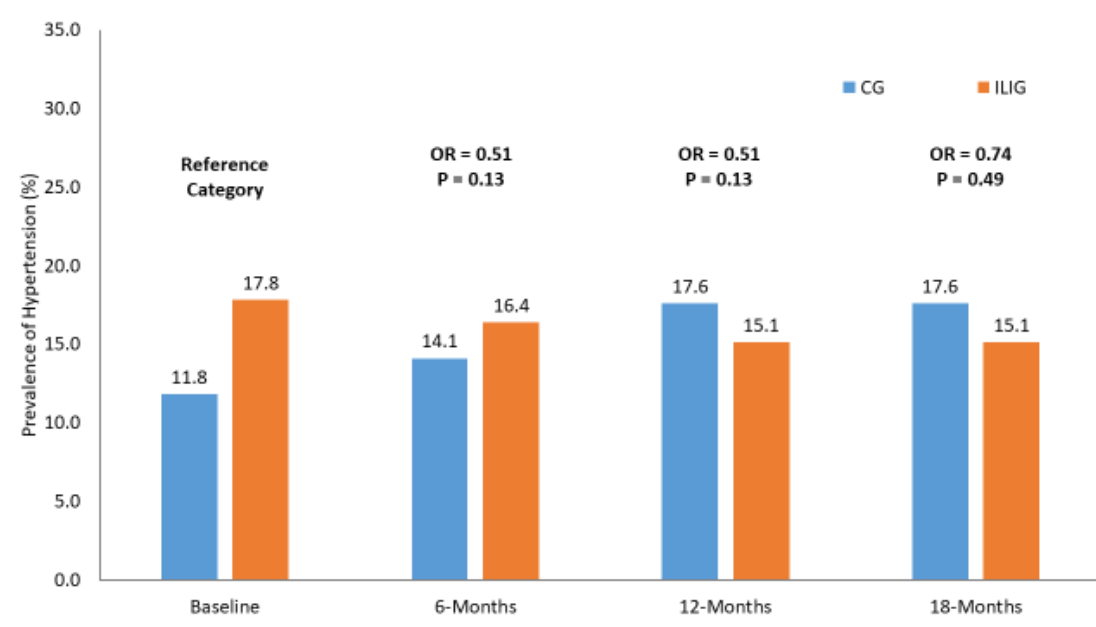
Figure 2. Prevalence of hypertension in both groups over time .